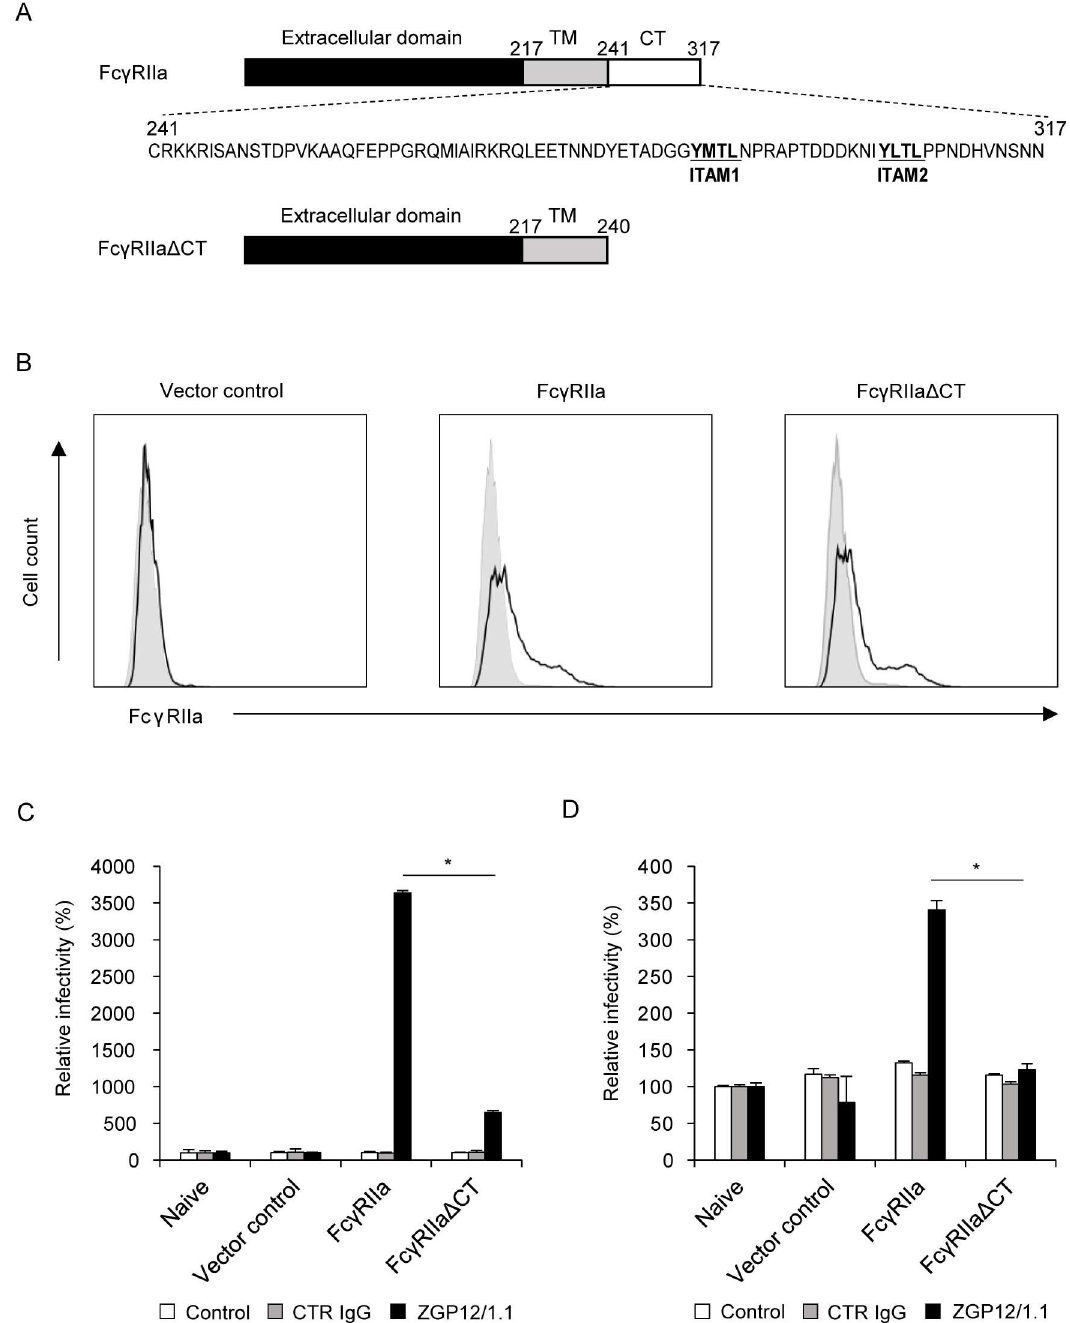
Fig 1. Importance of Fc γ RIIa and its cytoplasmic tail in EBOV ADE. (A) Schematic representation of Fc γ RIIa and Fc γ RIIa Δ CT. TM, transmembrane region; CT, cytoplasmictail. (B) Cell surface expressionof the Fc γ RIIa ectodomainon Jurkat T cell lines. Jurkat T cells stably expressingFc γ RIIa and Fc γ RIIa Δ CTwere stained with an anti-CD32antibody and analyzedby flow cytometry. Black lines represent vector-transduced, Fc γ RIIa-, and Fc γ RIIa Δ CT-expressing cells. Gray shadingrepresentsnaive Jurkat T cells. (C, D) Infectivity of VSV-EBOV GP and EBOV in Jurkat T cell lines. VSV-EBOV GP (C) and EBOV (D) were incubatedwith medium alone (Control), CTR IgG, or ZGP12/1.1, followedby inoculationinto each Jurkat T cell line. At 24 h (C) and 72 h (D) after inoculation, GFP-positive cells were counted. The relative infectivity in each cell line was calculatedby setting the IU value of untreated(Control), CTR IgG-, and ZGP12/1.1-treated viruses in naive Jurkat T cells to 100%, respectively. The mean and standard deviationof three independentexperiments are shown. Statistical analysiswas performed using Student’s t -test ( * p < 0.05).